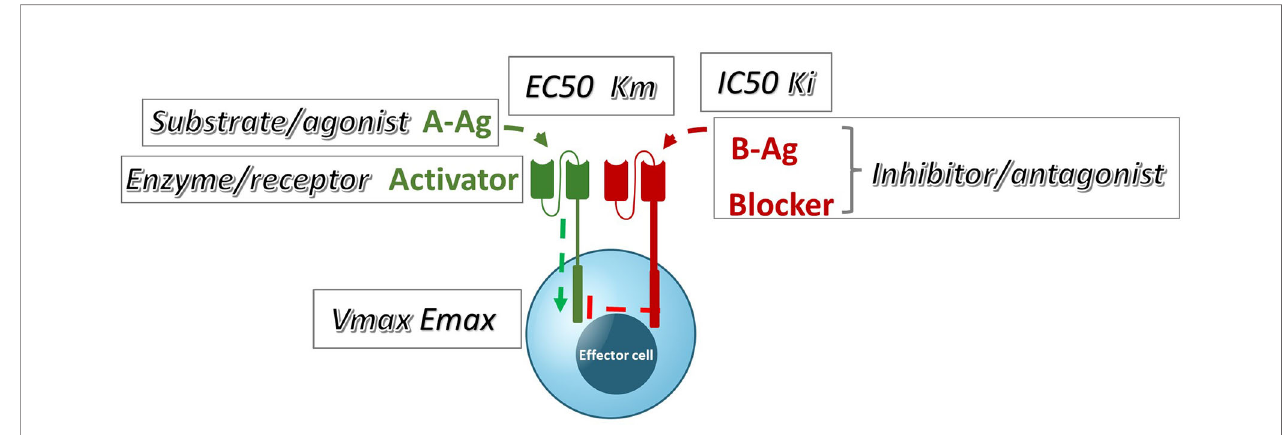
FIGURE 8 | A qualitative comparison of pharmacologic Tmod parameters measured in Jurkat cells and their corresponding analogous Michaelis-Menten or receptor signaling